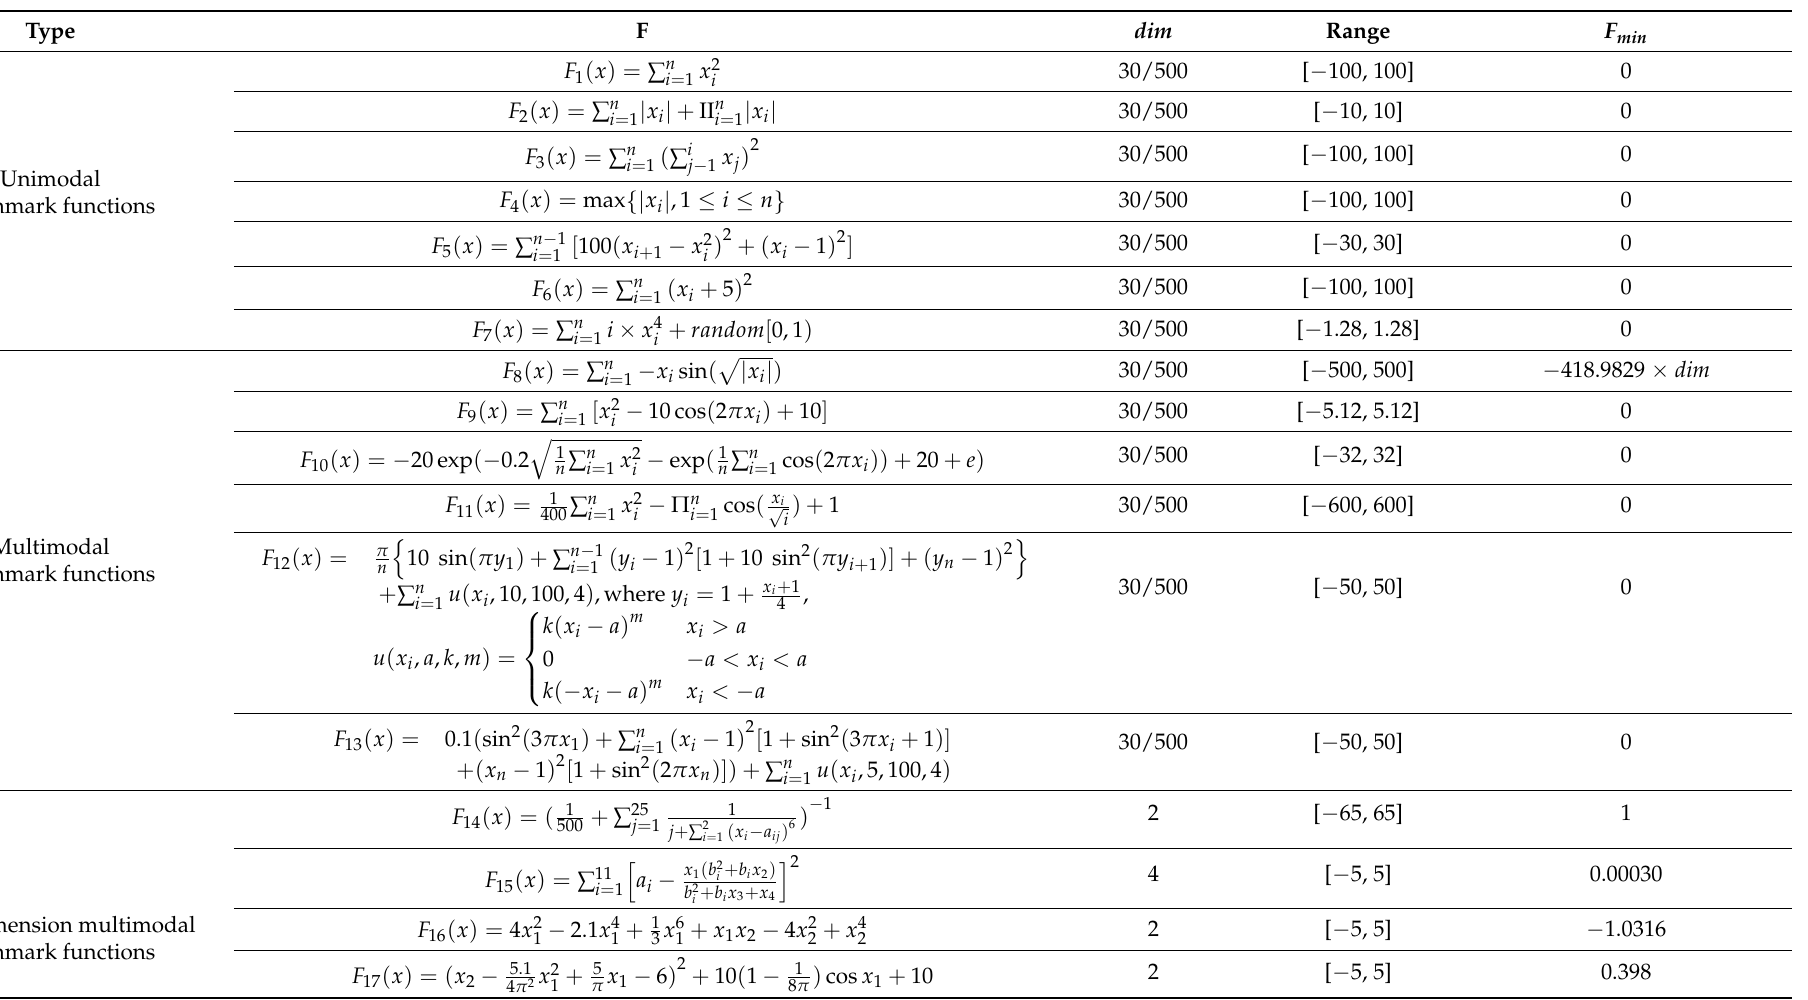
Table 2. Details of 23 benchmark